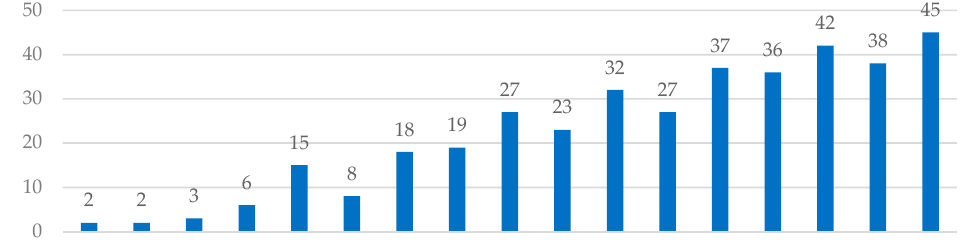
Figure 1. Annual publications.